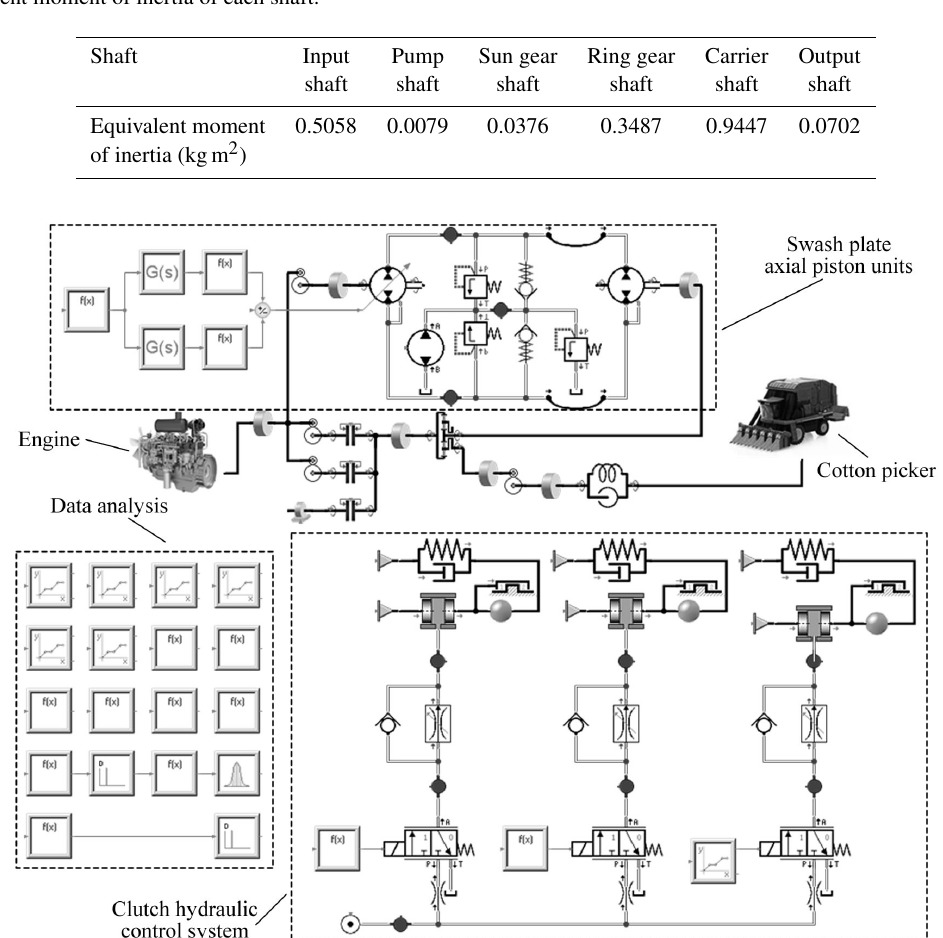
Table 3. Equivalent moment of inertia of each shaft.